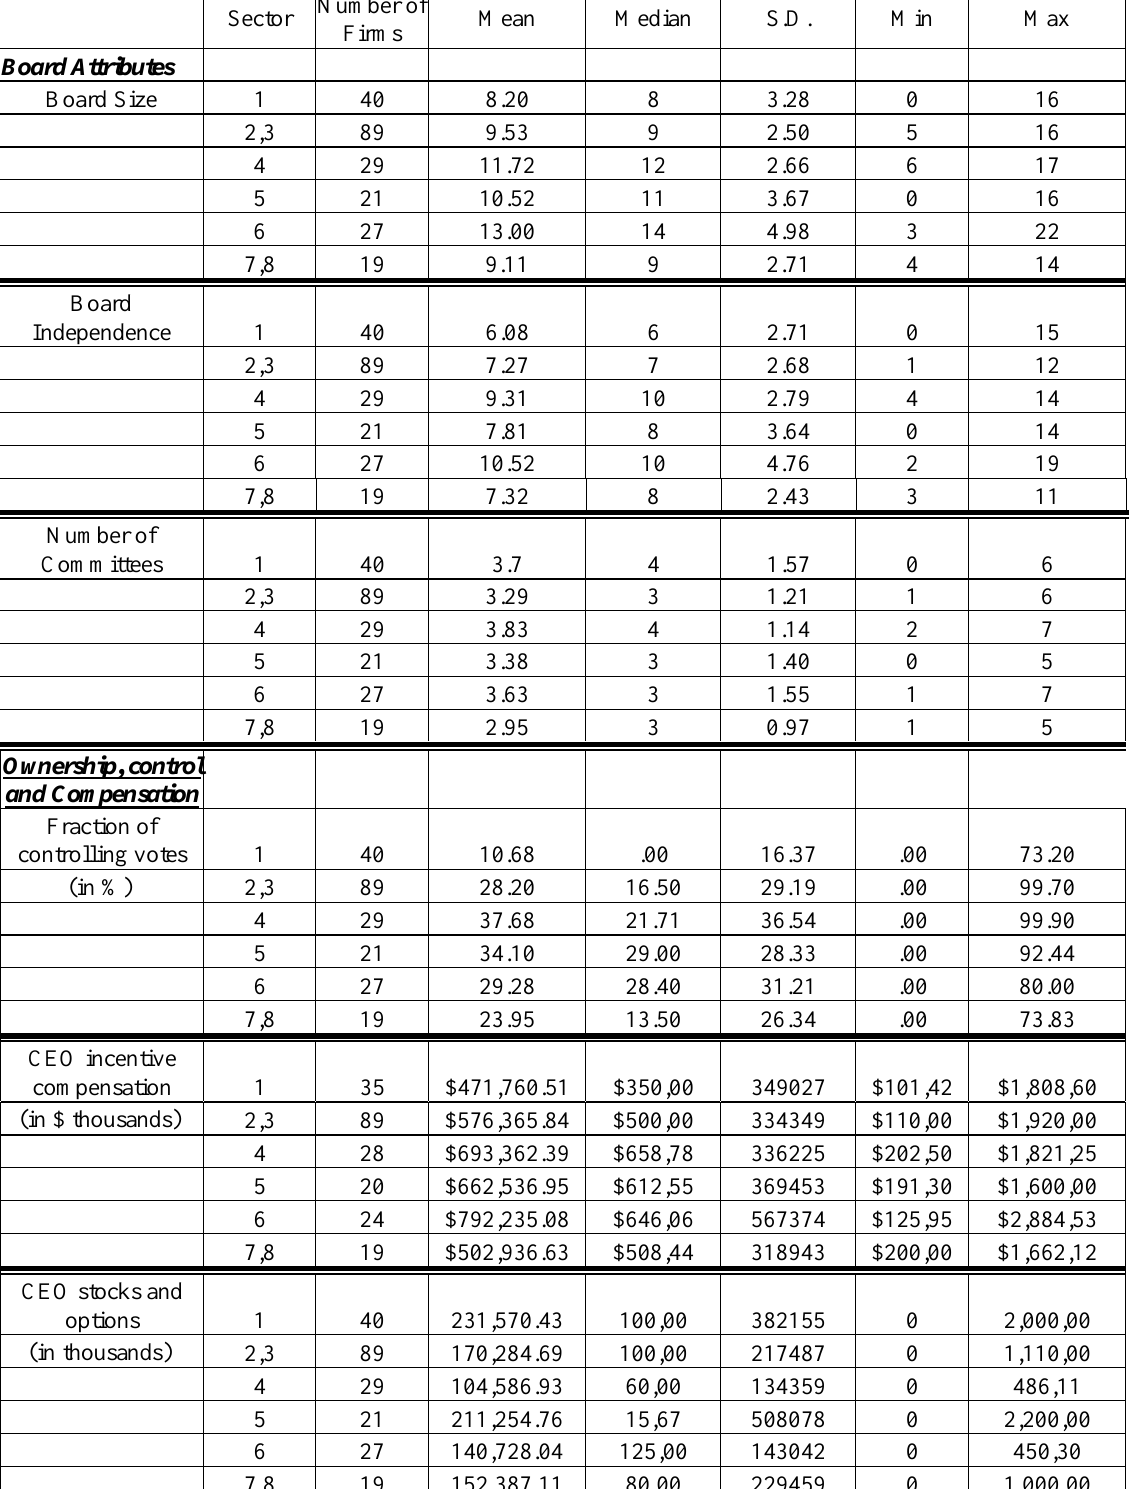
Table 1 : Corporate Governance and Risk Disclosure: Sample Descriptive Statistics Panel A : Corporate Governance Charateristics Board Attributes